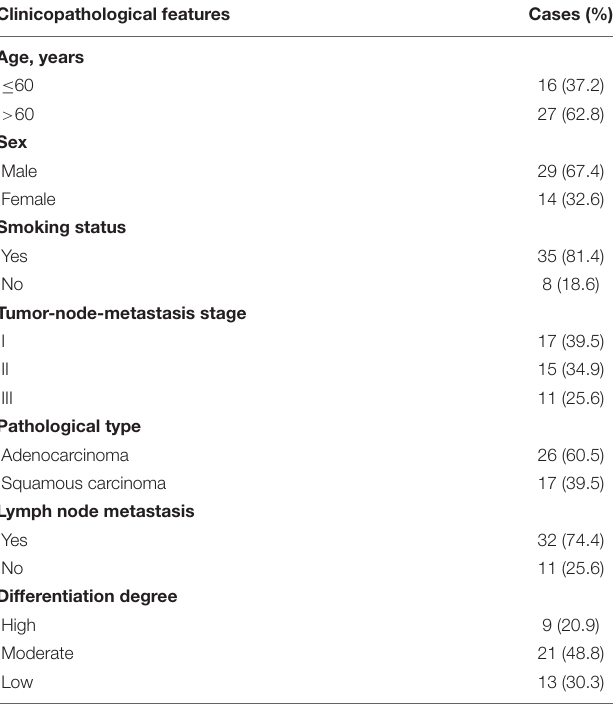
TABLE 1 | Clinicopathological features of the 43 patients with lung cancer in the present study. Clinicopathological